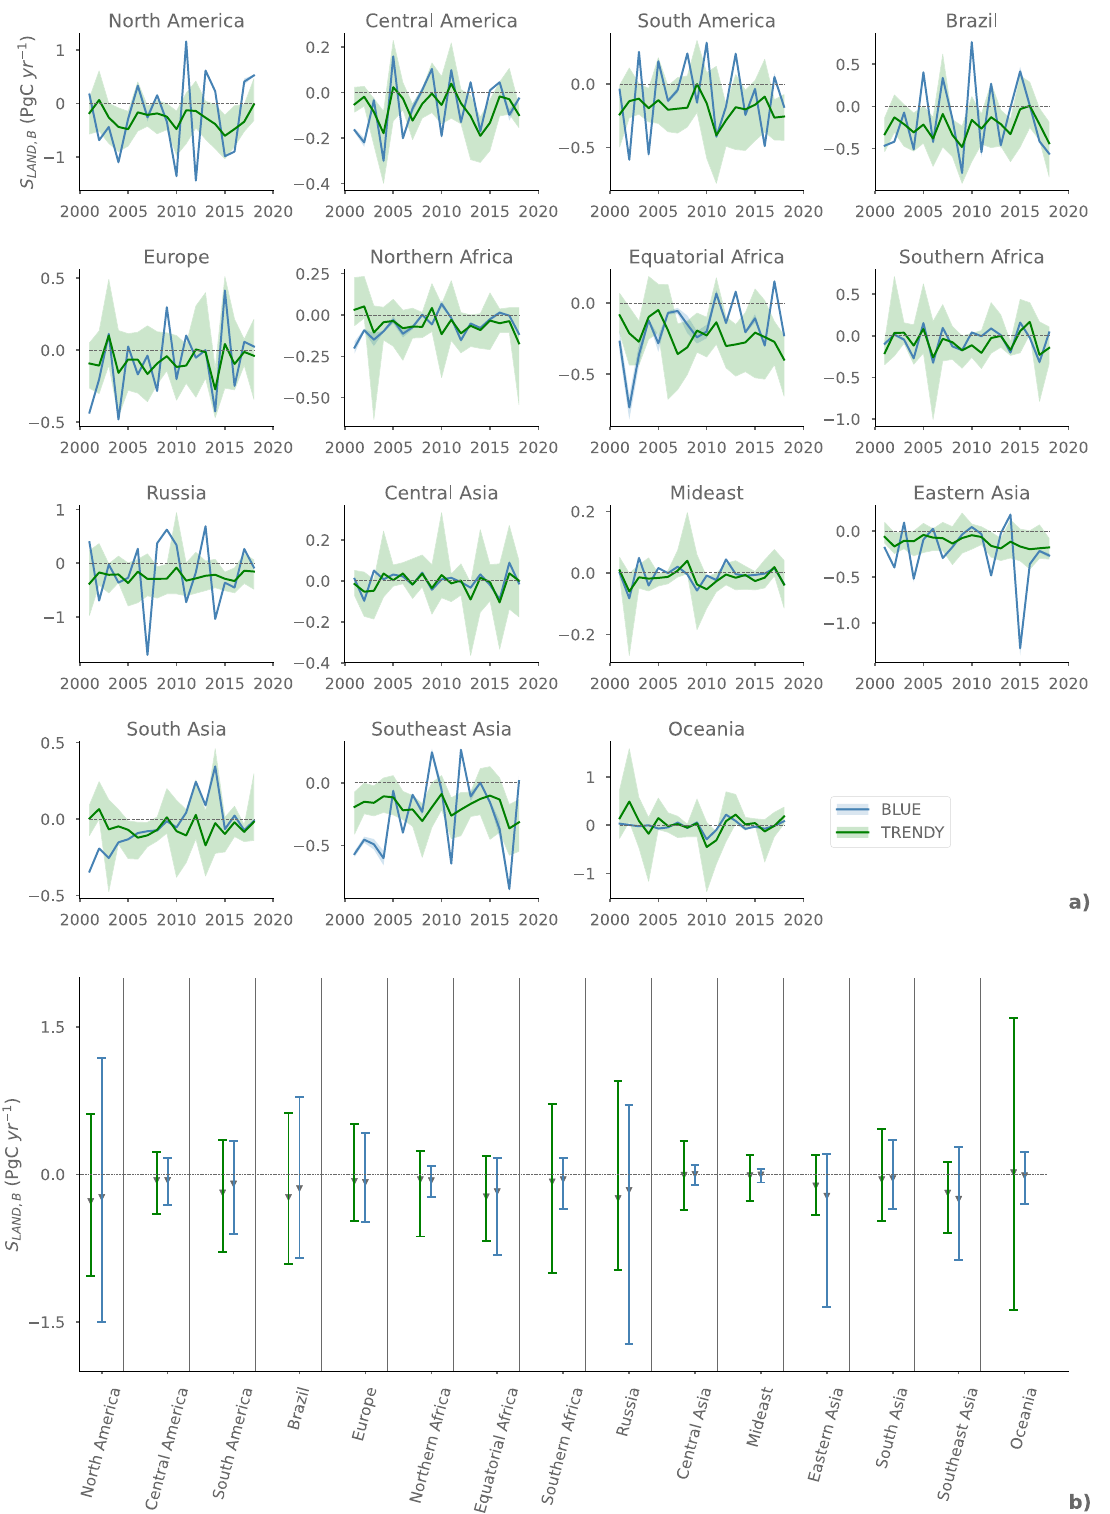
Fig. 1 | Regional estimates of the natural biomass land sink ( S LAND, B ) between 2001 and 2018. The fi gures compare the estimates by 13 DGVMs of the TRENDY model-intercomparisonproject(v8)vs.ourobservation-basedestimateswithBLUE (woody vegetation only). The temporal evolution for each region between 2001 and 2018 is shown in a . The lines mark the TRENDY multi-model average resp. the BLUE average from two threshold approaches to exclude unrealistically high woody biomass carbon densities (see Supplementary materials). The TRENDY